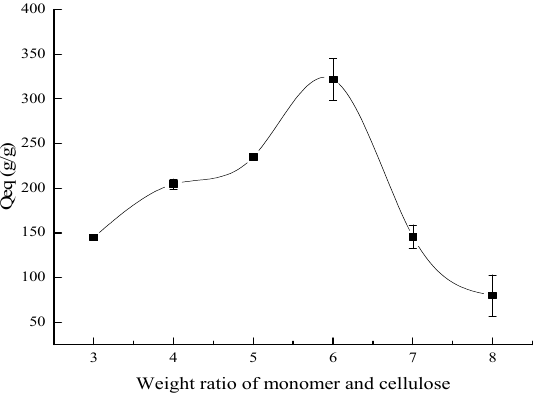
Figure 2. The influence of the ratio of AA/BC on the water absorbency.